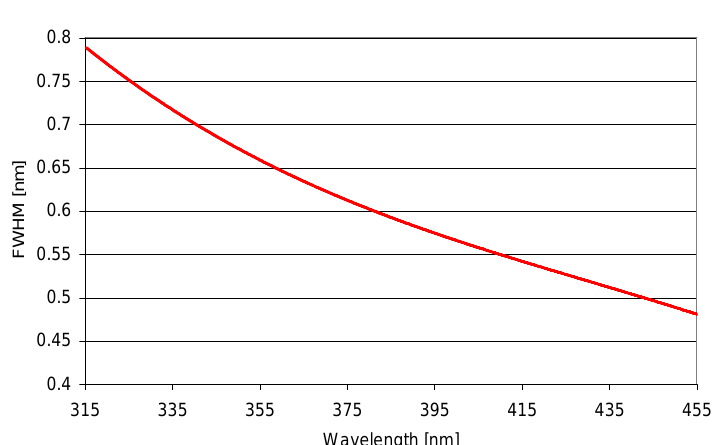
Figure A1. Spectral resolution (full width at half maximum, FWHM) as a function of wavelength determined from a fit to a high-resolution solar spectrum.